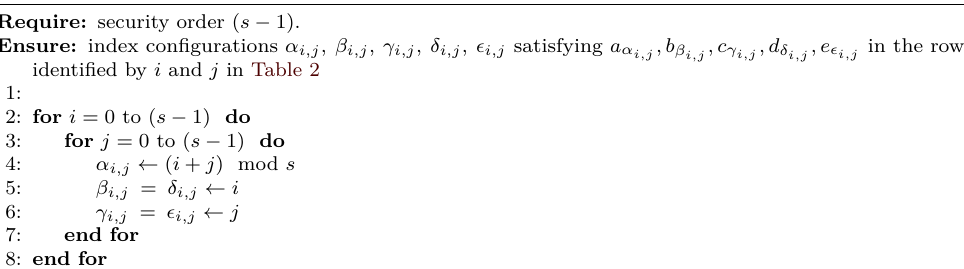
Algorithm 1 Generating index configurations for output bits in χ